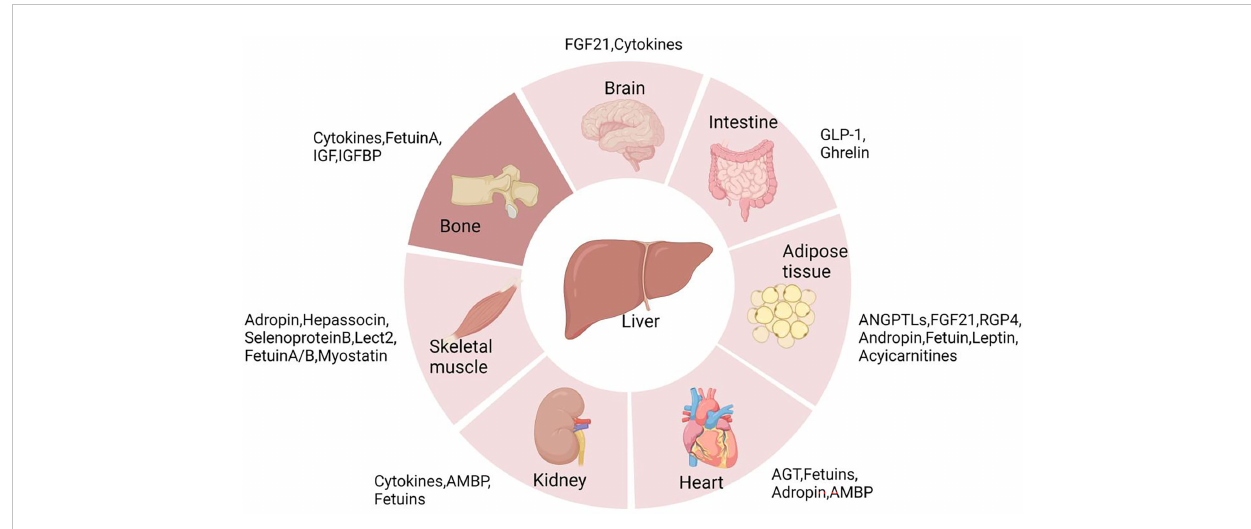
FIGURE 1 Communication between liver and distant organs. Liver is the metabolic center of the body. Because it is distant from many organs, liver usually secretes a variety of signaling molecules like hepatokines, cytokines, and enzymes into the circulation to modulate the function and metabolism of other